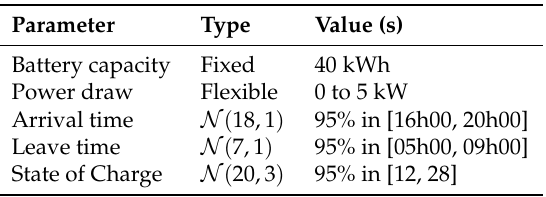
Table 1. Values for the EV